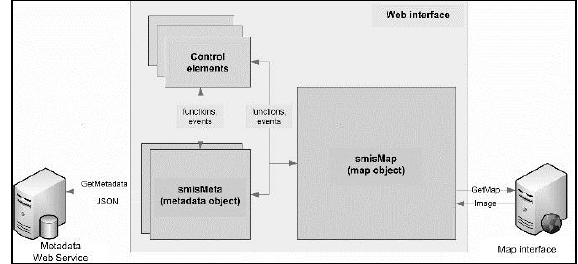
Figure 2. Presentation level architecture.